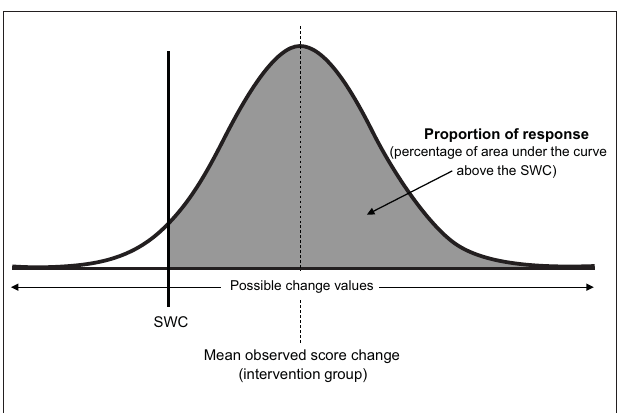
FIGURE 6 | Proportion of intervention group response. SWC, smallest worthwhile change; σ IR , Intervention response standard deviation.